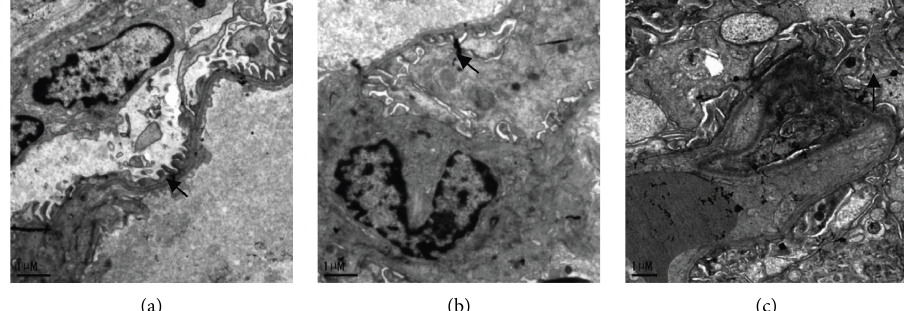
Figure 2: DN group. (a) Double-rail phenomenon appears in basement membrane, quantities of podocyte reduced and fused. (b) Podocyte flatted, fused, decreased, podocyte width enlarged, inflammatory cells of mesangial region appeared. (c) Basement membrane had plenty of dense deposits and it was vague and unclear, podocyte flatted, decreased, podocyte width